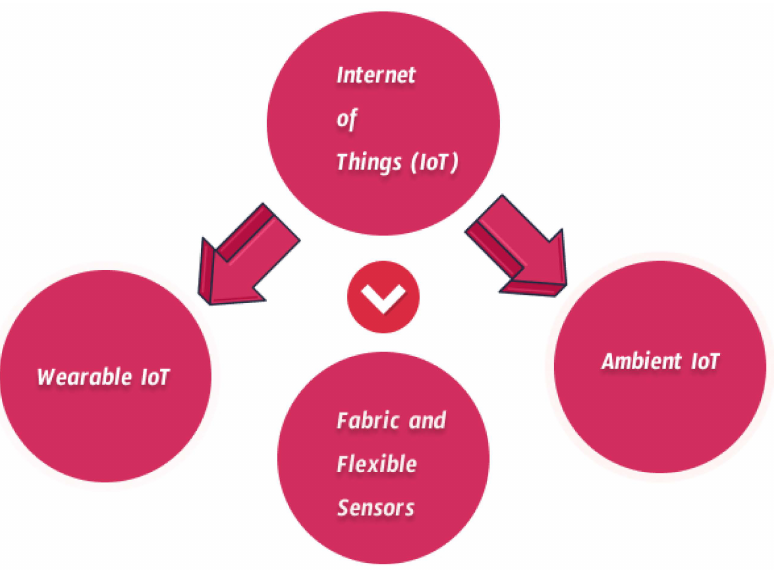
Figure 3. Different types of IoT Technology for Healthcare 4.0